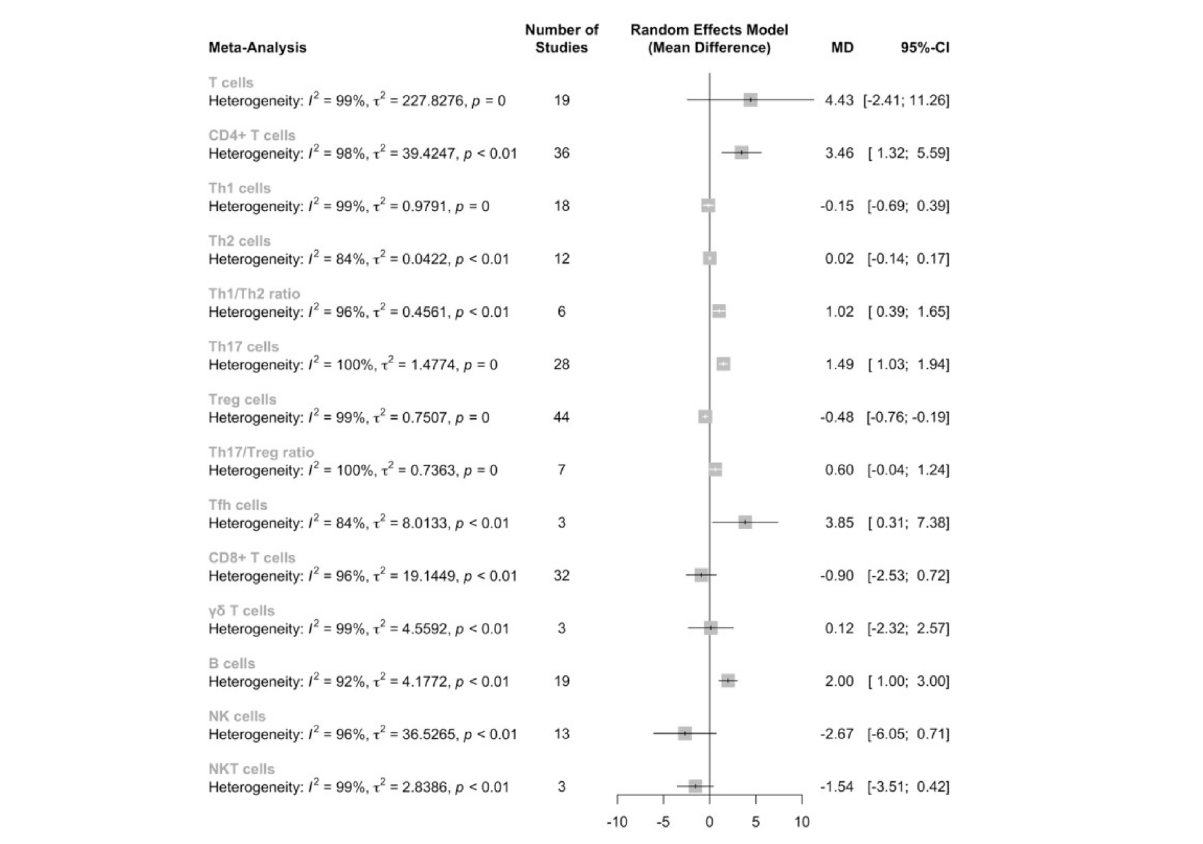
FIGURE 2 | Proportions of major lymphocyte subsets in the peripheral blood of AS